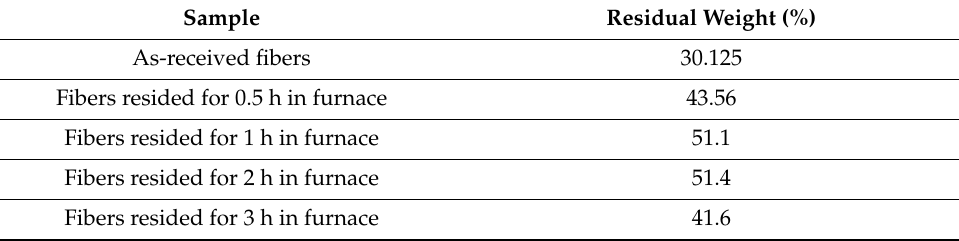
Figure 5. Thermal gravimetric analysis (TGA) Thermograms of (as-received fibers, fibers stabilized for 0.5 h, fibers stabilized for 1 h, fibers stabilized for 2 h and fibers stabilized for 3 h). Table 2. Residual weights of the as-received fibers and thermally stabilized fibers.